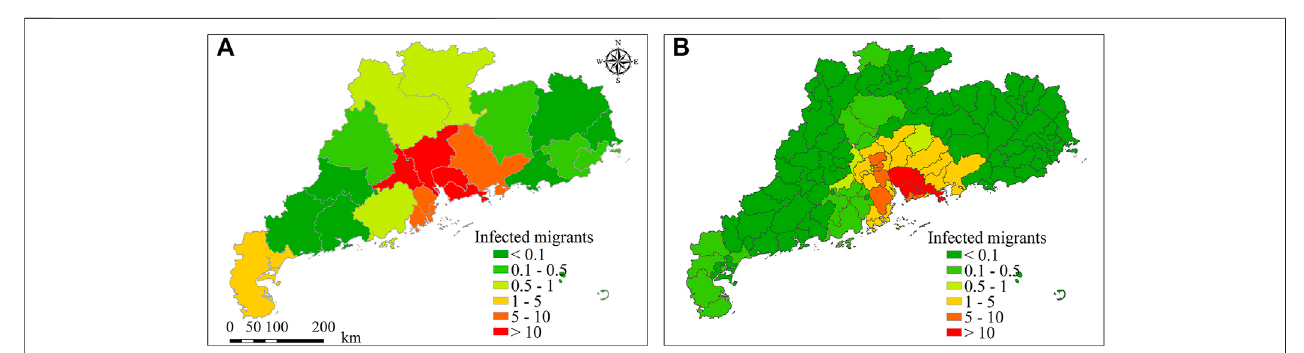
FIGURE 8 | Spatial distribution of possible COVID-19 infected migrants in Guangdong at the city (A) and county (B) levels.